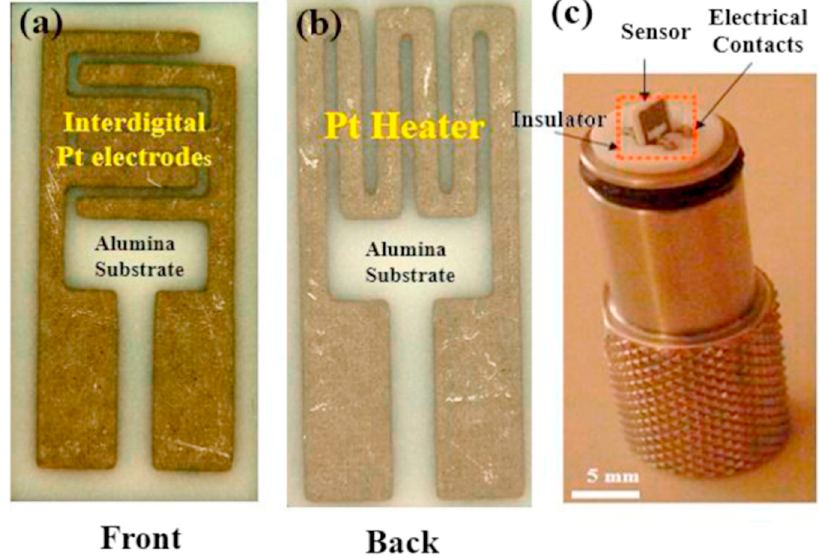
Figure 1. ( a ) Front side of substrate equipped with electrodes, ( b ) back side of substrate equipped with a heater, ( c ) sensor holder [35].